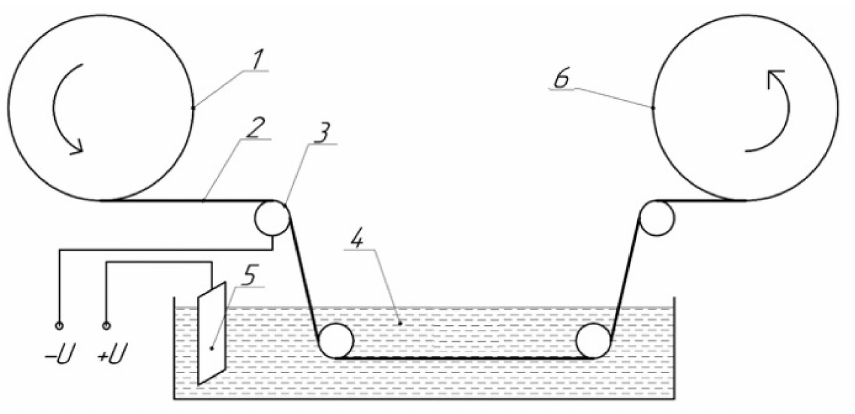
Figure 1. Coating deposition